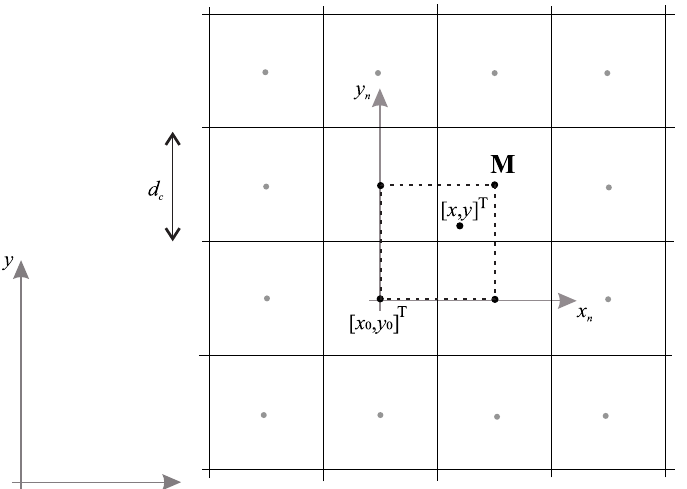
Figure 4. Selection of the cell neighbourhood for the bicubic interpolation of the potential field based on a point [ x , y ] T within the cell M